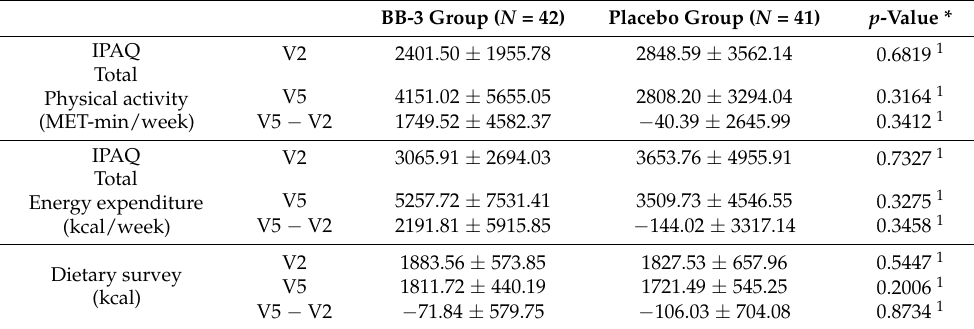
Table 1. Changes in physical activity and dietary habits